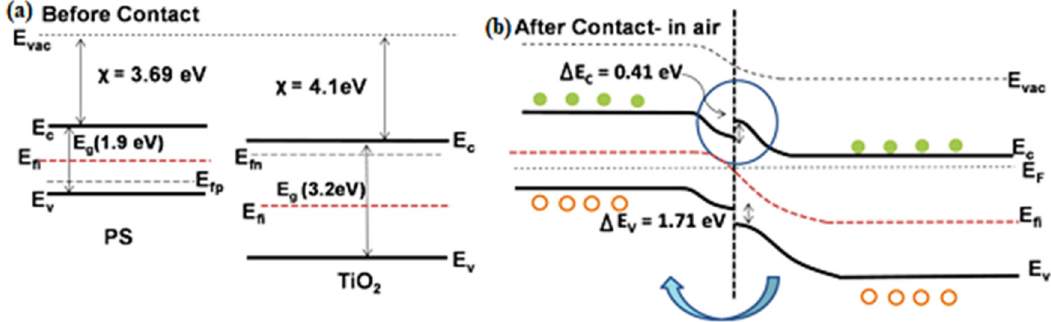
Figure 6. Band diagram of the TiO 2 decorated PSi heterojunction ( a ) before contact, ( b ) after contact (in air) [120].